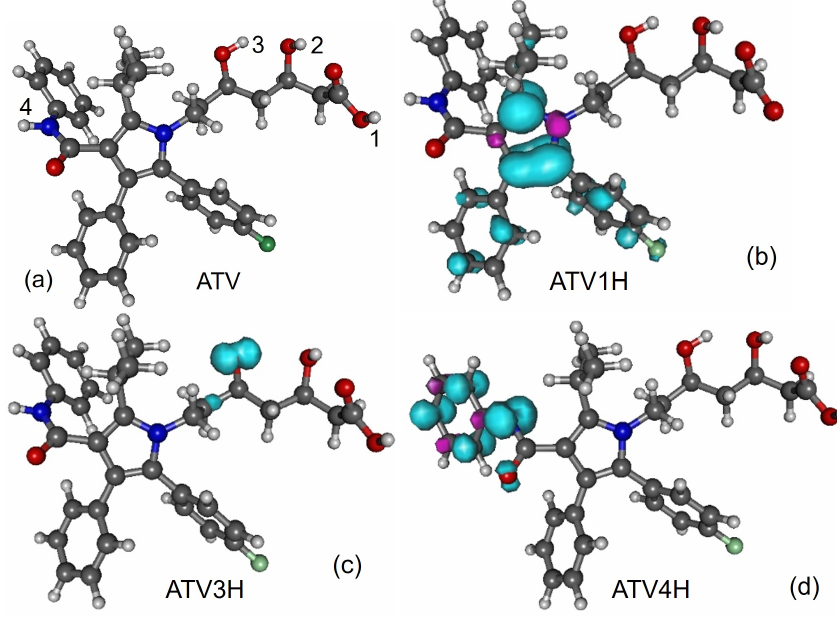
Figure 1. ( a ) Optimized ATV geometry. Spin densities of neutral radicals generated from it by H-atom abstraction at positions indicated in the inset: ( b ) ATV1H, ( c ) ATV3H, and ( d ) ATV4H. Figure generated using GABEDIT